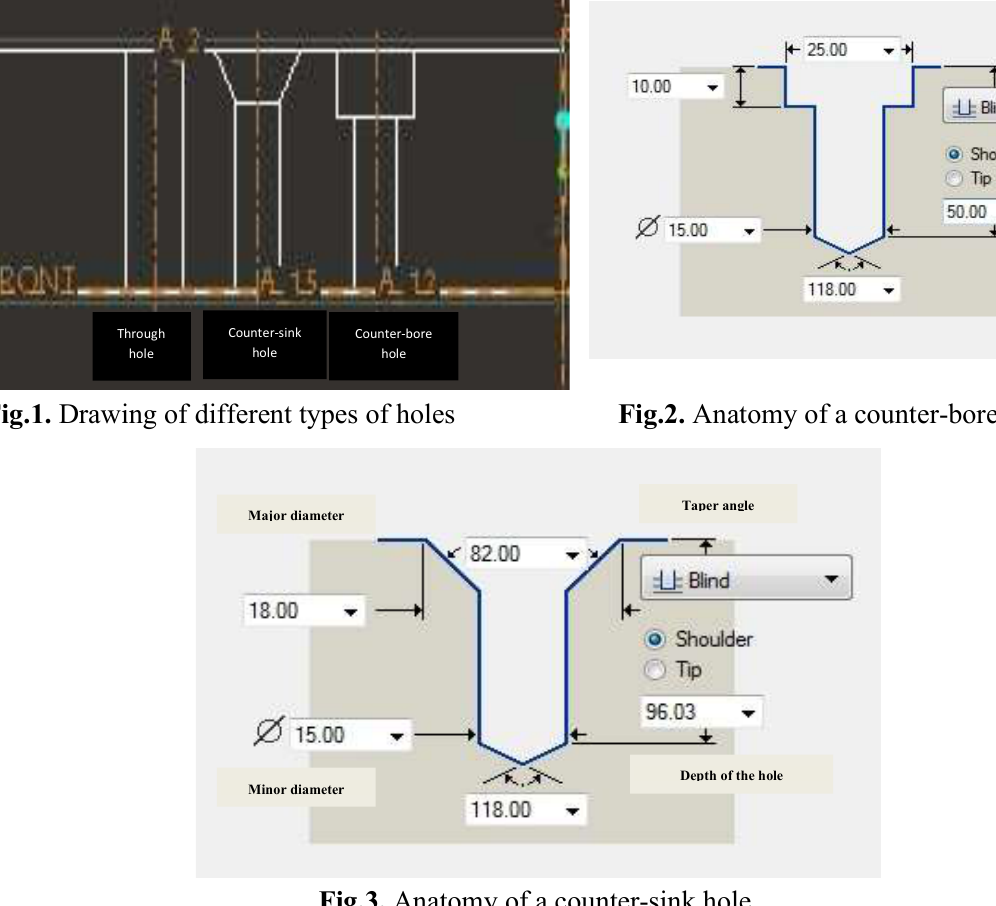
Fig.3. Anatomy of a counter-sink